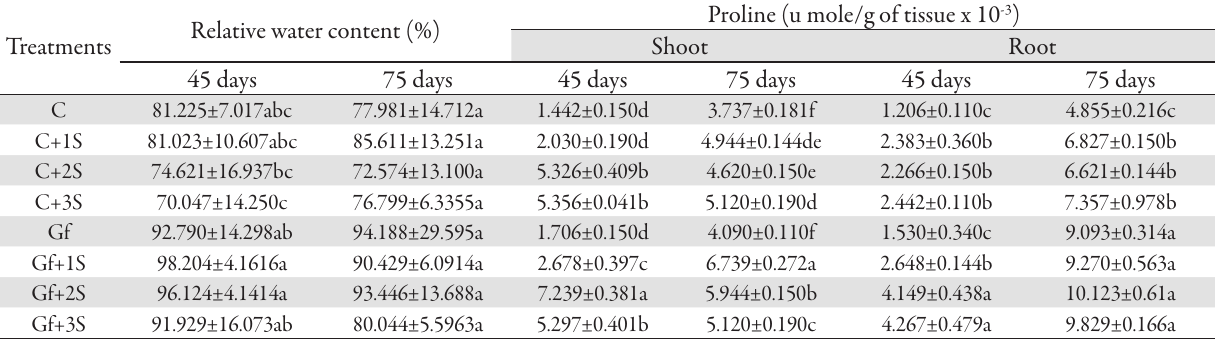
Tab. 2. Relative water content, shoot and root proline accumulation in Allium sativum L. after 45 and 75 days of AM treatment under non- salinity and salinity